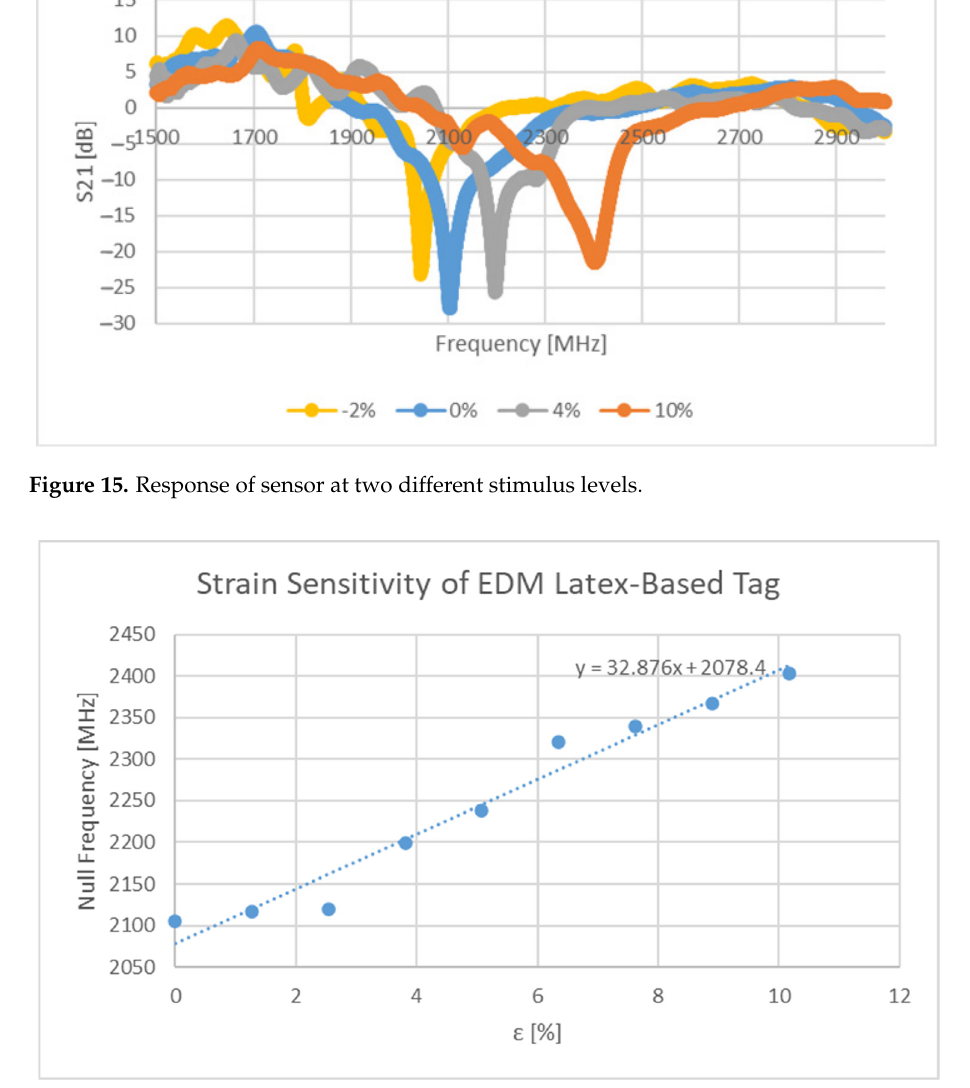
Figure 16. Sensitivity plot of physical sensor.